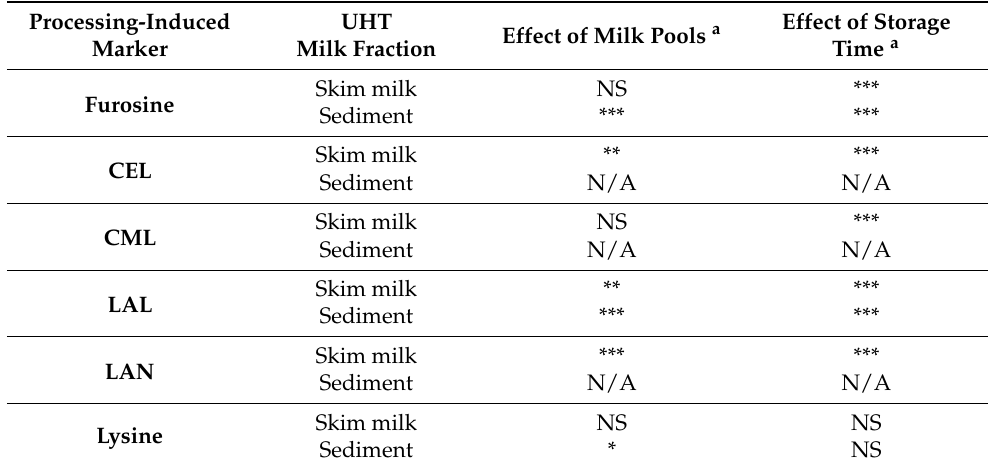
Table 1. The two-way analysis of variance test (ANOVA) between milk pools (small and large casein size milk) and storage time after UHT processing (0 to 6 months). Differences were considered statistically significant when p ≤